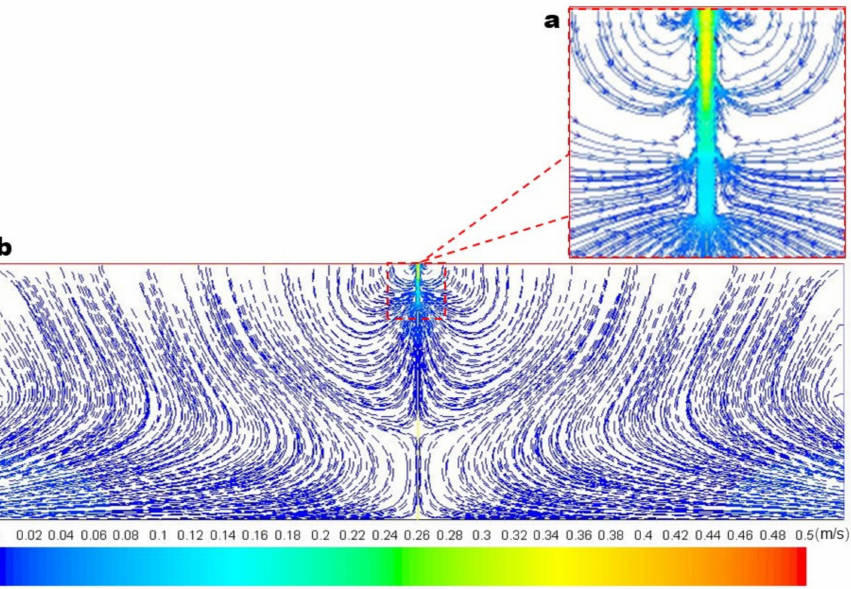
Figure 8. Hydrodynamic analysis of the 4mG-Lift device in lake water. ( a ) Hydrodynamics around the 4mG-Lift; ( b ) hydrodynamics of the whole